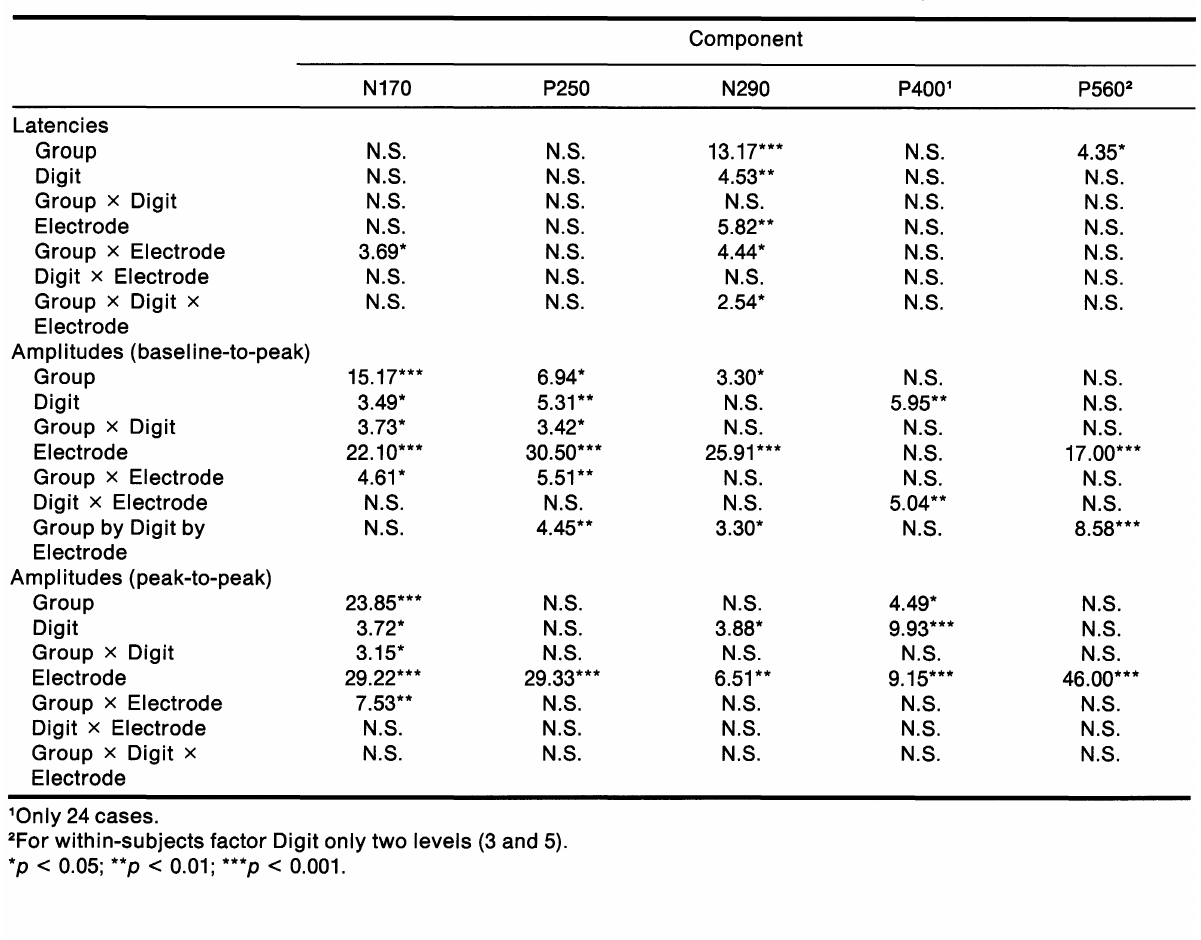
TABLE II. F values for repeated measures MANOVA of latencies and amplitudes including between-subjects factor Group (controls, patients) and within-subjects factors Digit (1,3, 5) and Electrode (Fz, Cz,